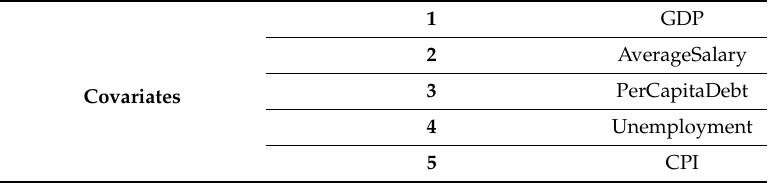
Table 2. Description of the network Volume. CPI: Consumer Price